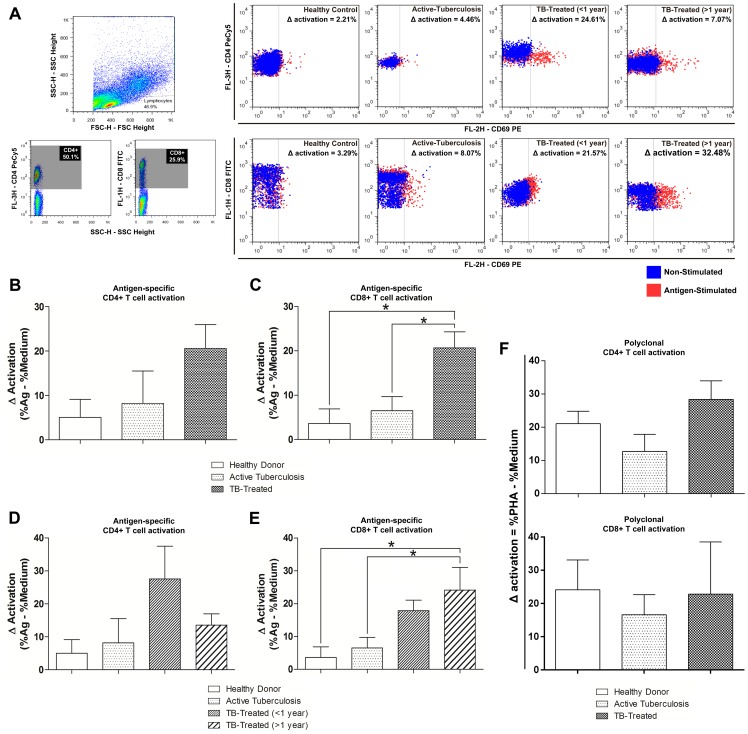
T cell activation in active and clinical cured tuberculosis.Variation in the activation of helper and cytolytic T cells in Healthy Donors, patients with active tuberculosis and clinically cured patients. A. Schematic representation of the gating strategy and determination of Δ activation of CD69+ cells in stimulated (4 µg/mL M. bovis antigen) and unstimulated (medium only) cultures. From left to right, T cells were separated based on FSC and SSC patterns. These cells were divided into CD4+ and CD8+ and the expression of CD69 was evaluated. Dot plots representative of each studied group are shown. Blue dots represent the staining for CD69 in unstimulated cultures, and red dots represent the stimulated cultures. The percentage of specific antigen activation was calculated by simple subtraction of the percentage of CD69+ cells in unstimulated cultures from the percentage observed in stimulated cultures and the Δ activation for each depicted dot plot is shown. The superior panel of dot plots represents the activation in CD4+, and the inferior panel represents the activation in CD8+. Dot plots representative of a single participant are shown. B, C. Comparison between Healthy Donors, Active-TB patients and TB-treated patients. D, E. Comparison between Healthy Donors, Active-TB and different times after clinical cure (TB-treated <1 year and TB-treated >1 year). F. Comparisons between Healthy Donors, Active-TB patients and TB-treated patients after culture in the presence of polyclonal stimulation– 2 ug/mL PHA (Polyclonal activation was calculated by simple subtraction of the percentage of CD69+ cells in unstimulated cultures from the percentage observed in PHA-stimulated cultures). Bars represent the mean and vertical lines the standard error. B, C, F. *p<0.0167: ANOVA test (followed by post-hoc Bonferroni test for multiple comparisons). D, E. *p<0.0083: ANOVA test (followed by post-hoc Bonferroni test for multiple comparisons).